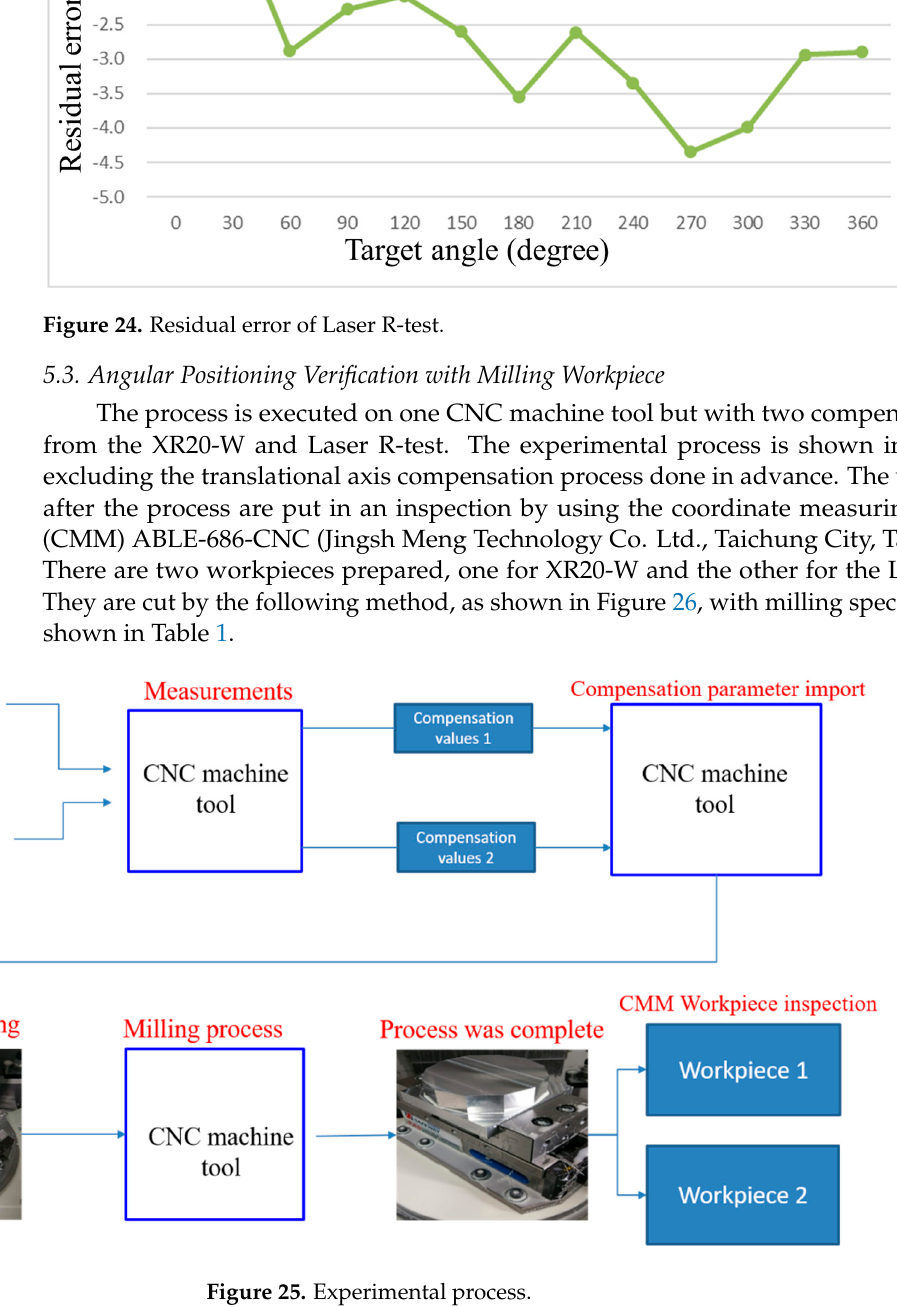
Figure 23. The angular positioning measurement (Laser R-test).